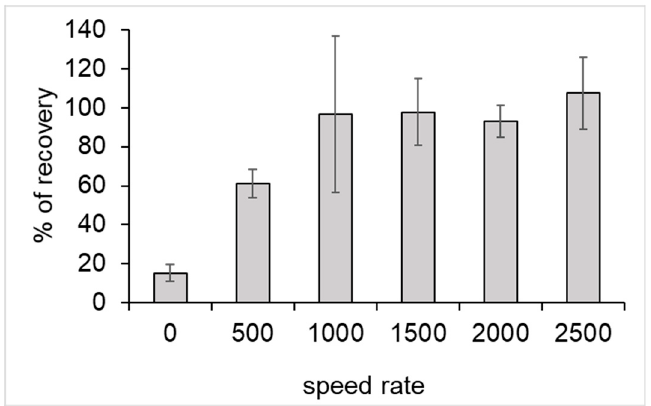
Figure 2. Percentage recovery of DNA in the speed rate agitation function. Error bars represent the standard deviation for n = 3.